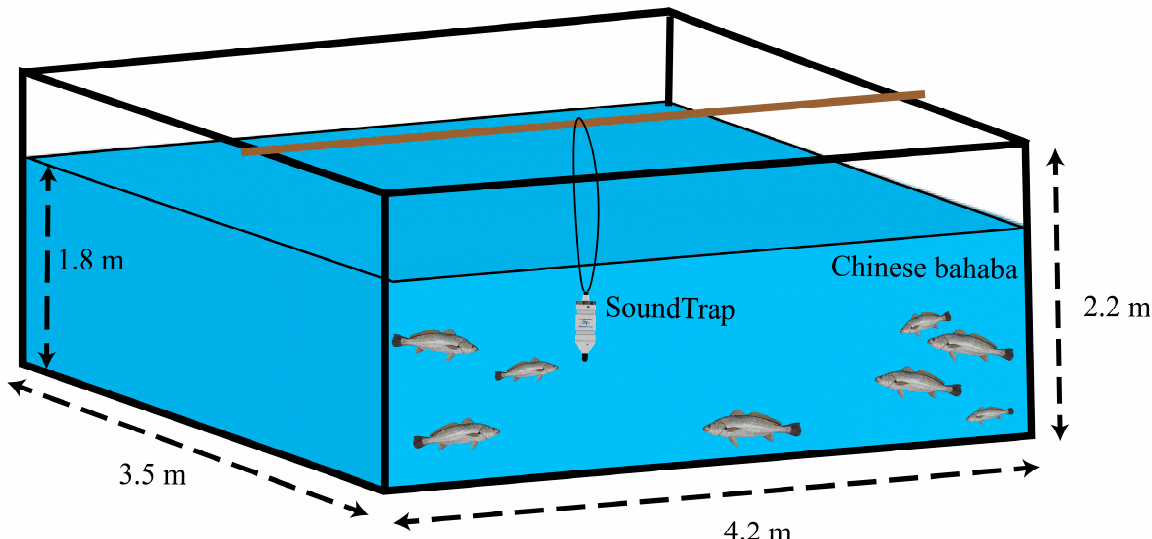
Figure 1. Acoustic recording of Chinese bahaba vocalization.